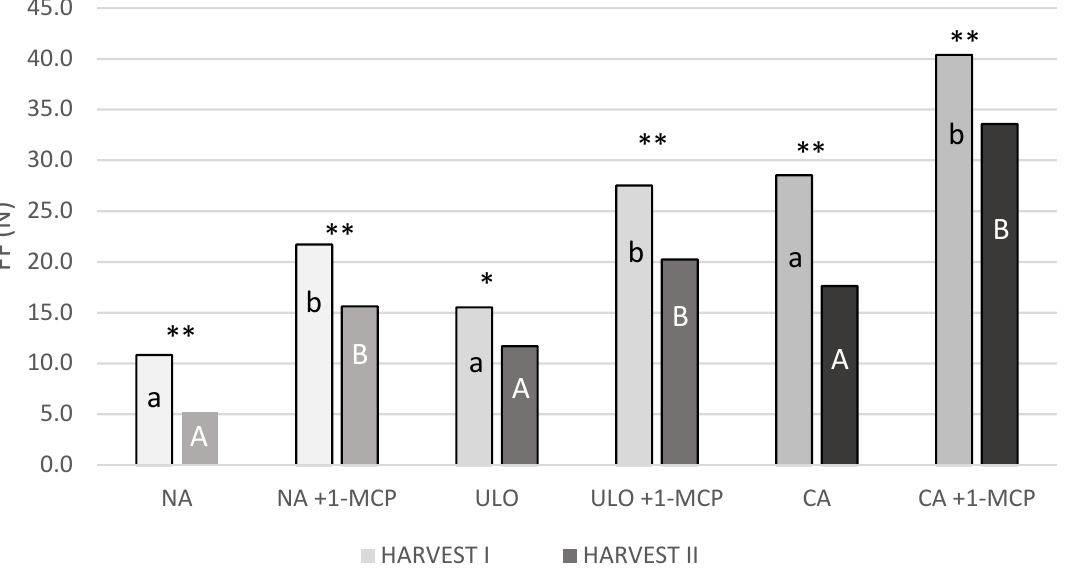
Figure 2. ‘Anansnaya’ fruit firmness (FF) depending on harvest time and 1-MCP treatment under three storage technologies. Statistically significant difference between first and second harvest fruit (Newman–Keuls range test): *—for 5%. **—for 1%. Different letters were assigned to statistically significant differences when comparing the effect of 1-MCP, separately for storage conditions. Table 2. Changes of firmness [N] measured in ‘Geneva’ mini kiwi fruit in the post-harvest period.